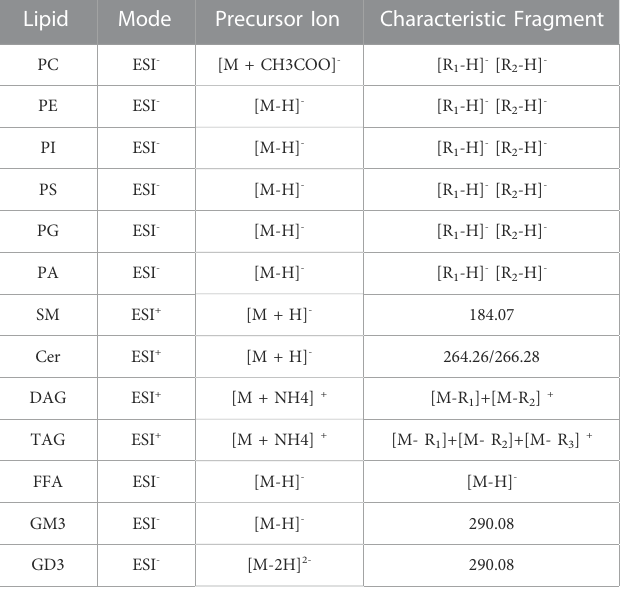
TABLE 2 Characteristic fragments of lipids by